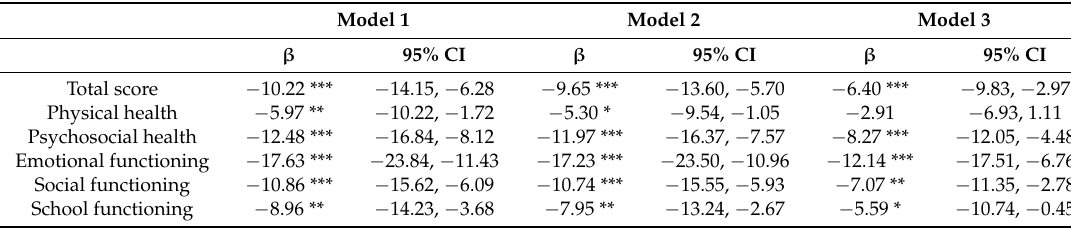
Table 3. Associations of food addiction and quality of